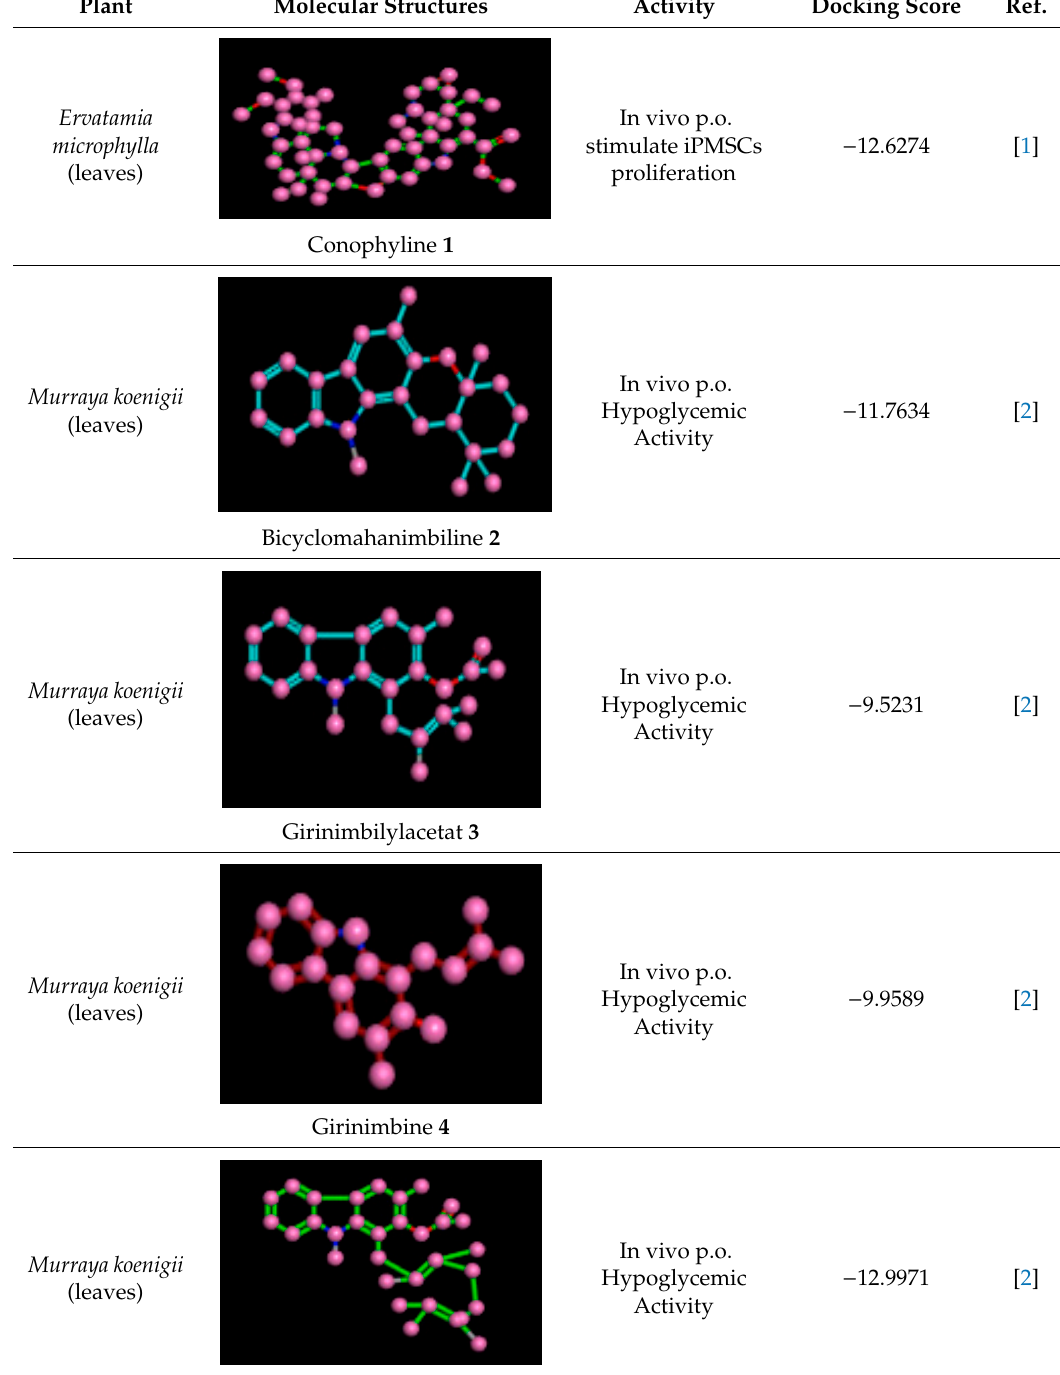
Table 1. Ligand chemical structures, their properties, and docking scores.